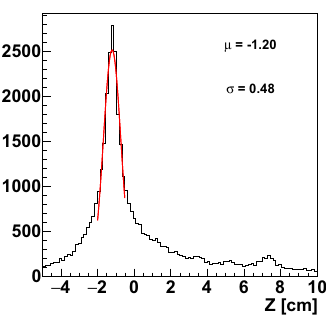
Figure 6. Distribution of z coordinate of the primary vertex. Interactions with the lead target are used for analysis